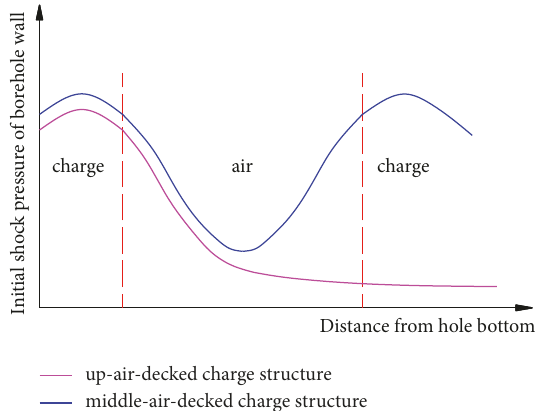
Figure 4: Variation in initial shock pressure of borehole